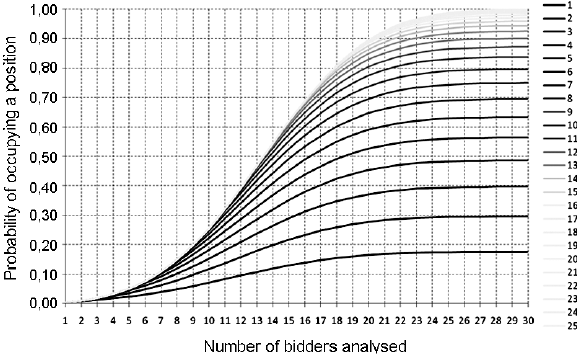
Fig. 2. Single bidder’s position performance calculation accuracy Figure 2 represents the stability (or accuracy) of po- sition calculations in Figure 3. Whenever curves repre-